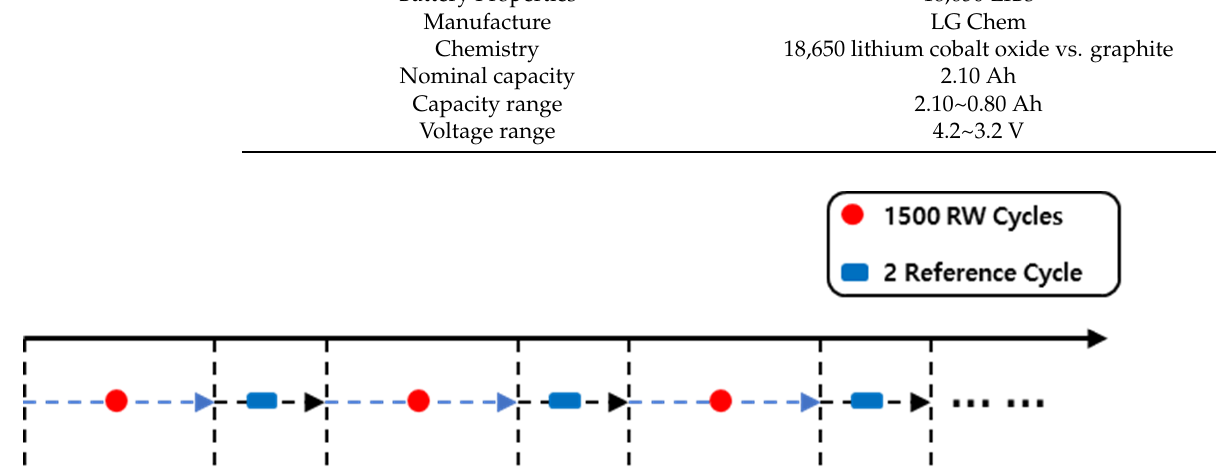
Figure 1. The whole process of data cycles.